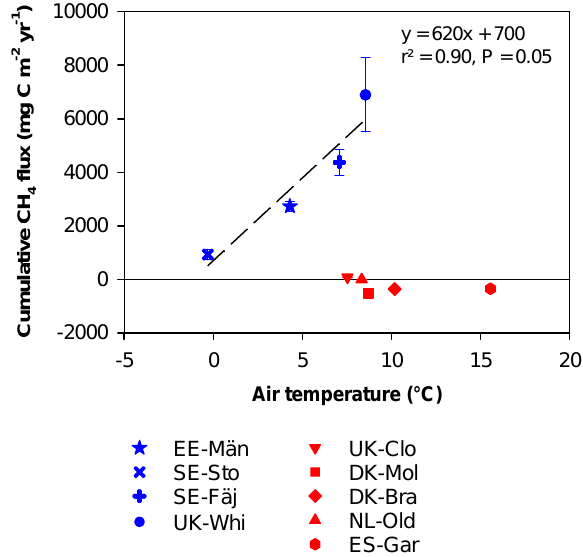
Fig. 2. Annual CH 4 flux related to mean annual air temperature in control plots at the nine sites (means ± SE). A linear regression line was fitted to data from the four peatland sites. Site codes are described in Table 1.